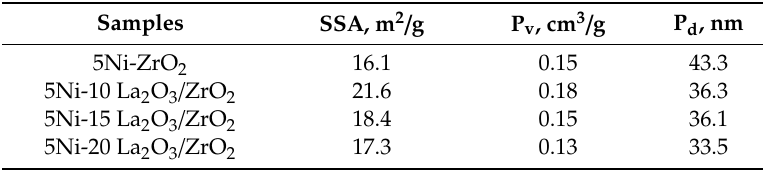
Figure 1. Figure 1. Nitrogen physisorption isotherms of 5Ni-ZrO 2 , as well as lanthanum-promoted 5Ni-ZrO 2 5Ni-ZrO 2 samples. samples. Table 1. Textural properties (specific surface area (SSA), pore volume (P v ), pore diameter (P d )) of the pristine and doped Ni-ZrO 2 samples.